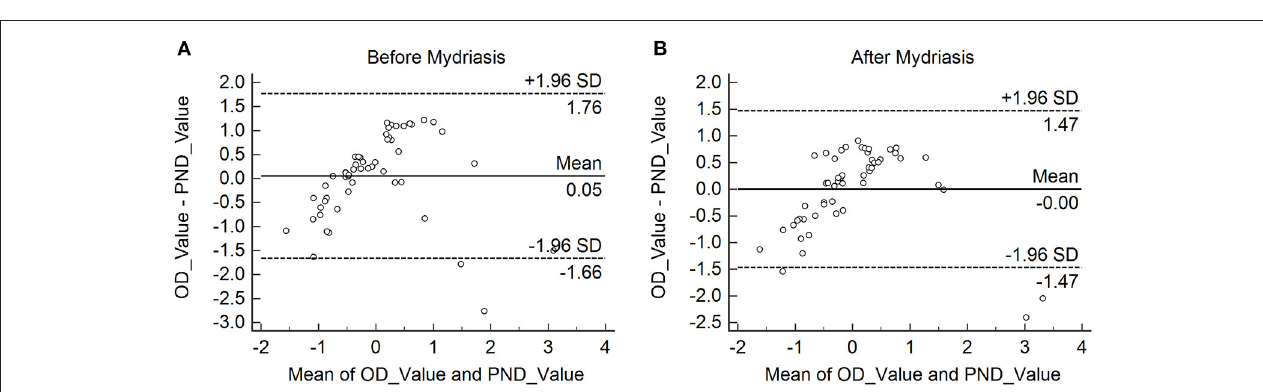
FIGURE 2 | Comparison of the lens density before and after mydriasis obtained with the IOLMaster 700 and the Pentacam Scheimpflug imaging. There was no significant difference between the two groups ( t = 0.455, p > 0.05) in the IOLMaster 700. The difference was statistically significant ( t = 2.509, p < 0.05) in the Pentacam Scheimpflug imaging. * p <